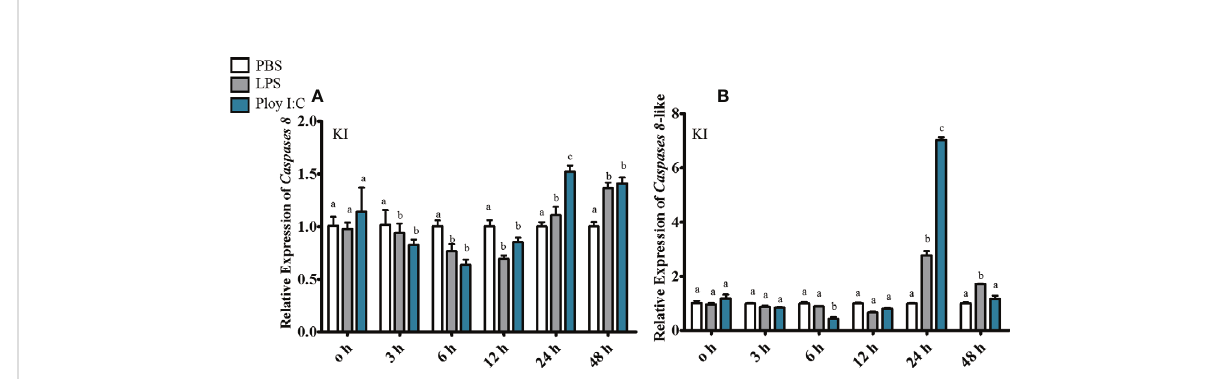
FIGURE 6 Real-time quantitative PCR was performed to detect cas8 [ (A) , Tocas8 ; (B) , Tocas8-like] mRNA expression levels in kidney after LPS and Poly(I:C) stimulation. b - actin was selected as an internal reference gene to calibrate cDNA template.These values are presented as mean ± standard deviation (n = 3).